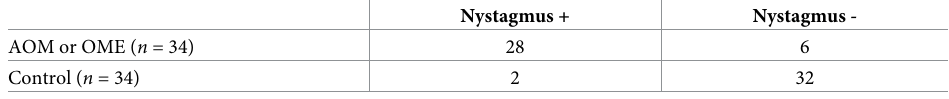
Table 5. Number of patients showing nystagmus in control subjects and patients with AOM or